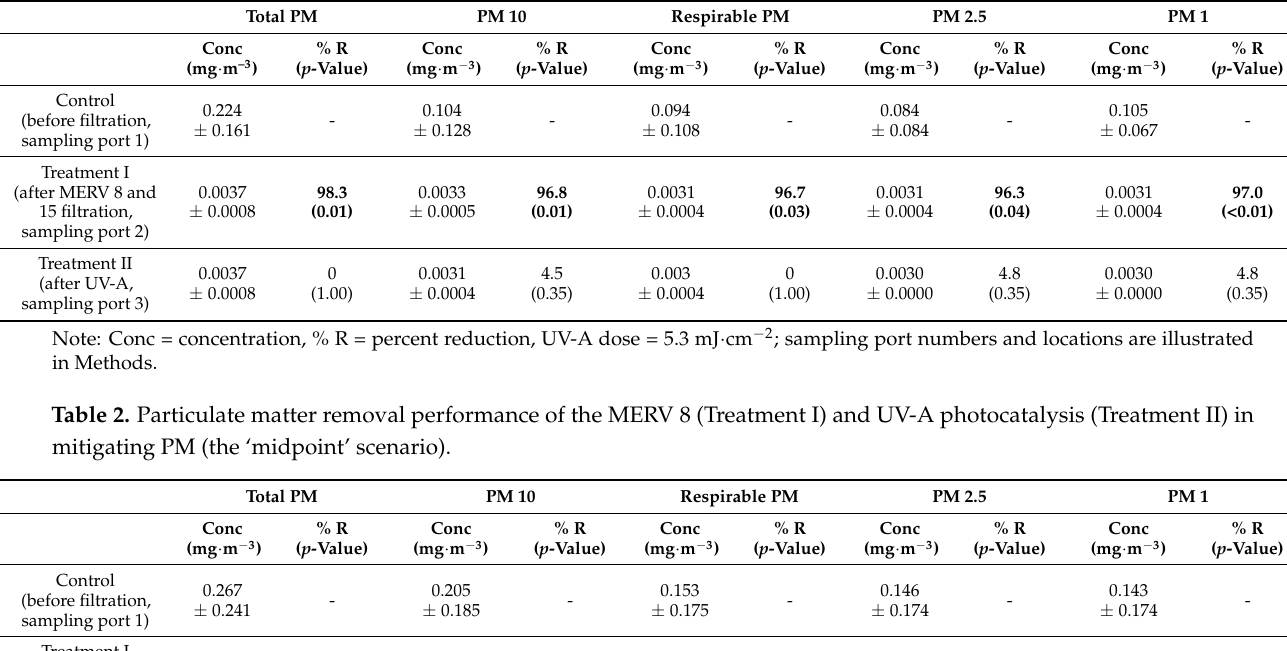
Table 1. Particulate matter removal performance of the MERV 8 and 15 (Treatment I) and UV-A photocatalysis (Treatment II) in mitigating PM (the ‘best-case’ scenario). Bold signifies statistical significance.